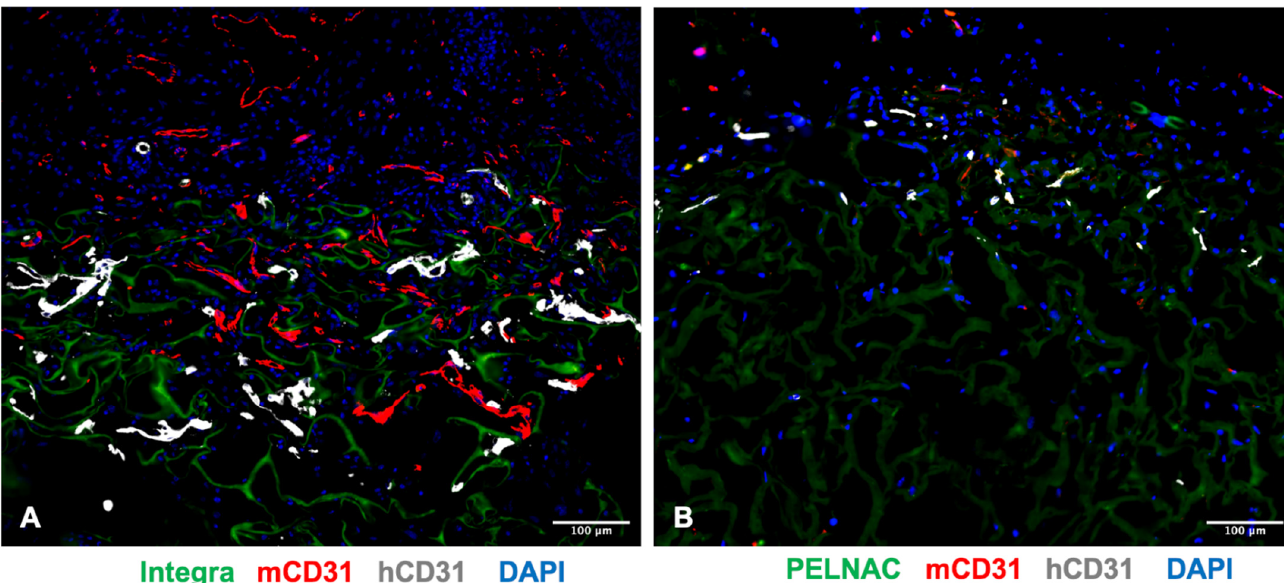
Figure 6. ADMECs engrafted and formed vascular structures on Integra ® but not on PELNAC ® . Representative images of the Integra ® ( A ) and PELNAC ® ( B ) scaffolds, populated by ADMECs at day 10 after subcutaneous cell implantation. Human and mouse ECs were stained using species-specific anti-CD31 antibodies. Both Integra ® and PELNAC ® are visible in green due to scaffold autofluorescence. Scale bar 100 μ m.